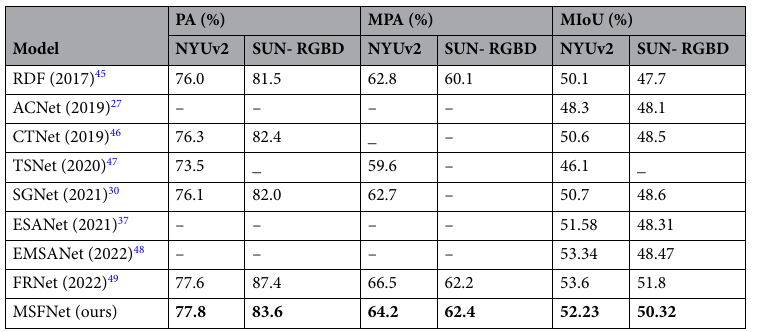
Table 5. Results on Datasets.